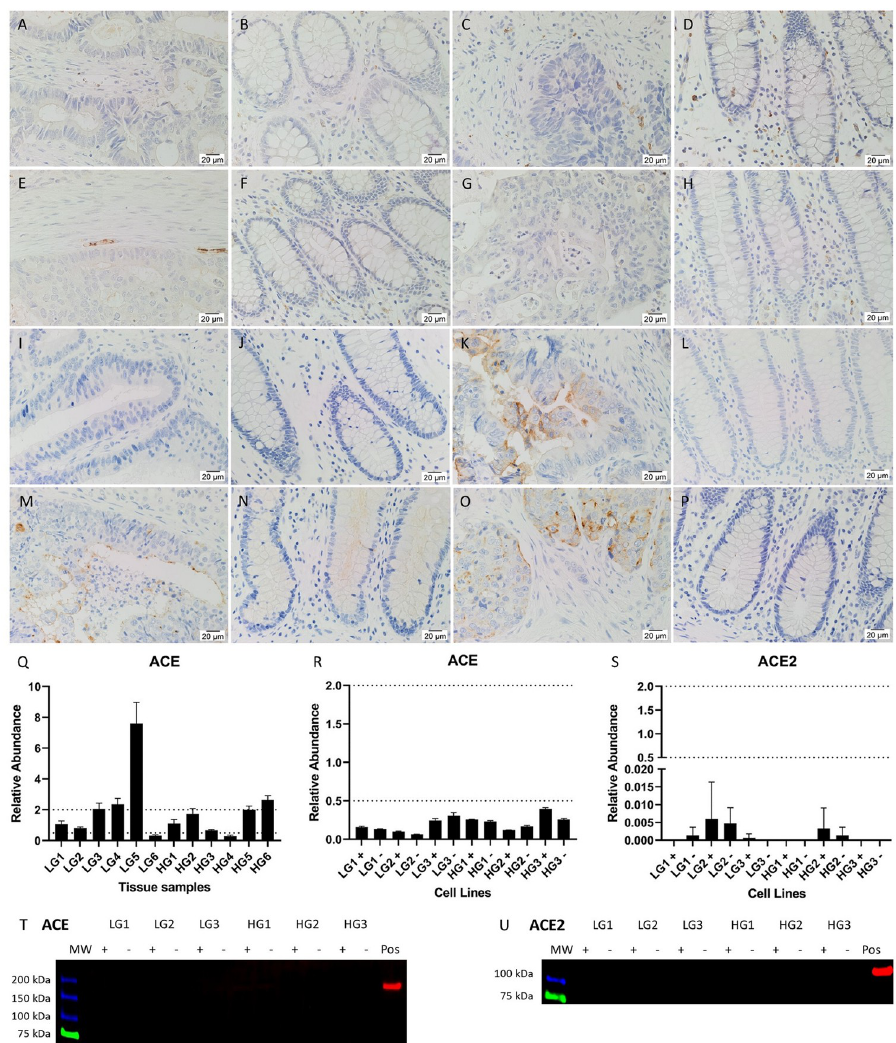
Fig 1. Expression of ACE and ACE2. Representative IHC stained images of ACE in 2 LGCA samples (A, C) and 2 HGCA samples (E, G) and their patient-matched NC) tissues (B, D, F, H), and ACE2 in 2 LGCA samples (I, K) and 2 HGCA samples (M, O) and their patient-matched NC) tissues (J, L, N, P). Nuclei were counterstained with hematoxylin (A-H, blue); original magnification: 400x. ACE (R) and ACE2 (S) mRNA expression levels were measured by RT-qPCR in 3 LGCA and 3 HGCA primary cell lines that were sorted into EpCAM High (+) and EpCAM Low (-) subpopulations. ACE mRNA expression levels were also measured in 6 LGCA and 6 HGCA tissues (Q). Abundance in CA tissues is displayed relative to patient-matched NC tissues, and relative to a pool of NC tissues for the CA-derived cell lines, with error bars representing standard deviation. ACE (T; 195 kDa) and ACE2 (U; 110 kDa) protein expression by cell lines could not be detected by WB; positive controls = mouse lung and human kidney, respectively. Adapted from [38] under a CC BY license, with permission from Munro MJ et al .